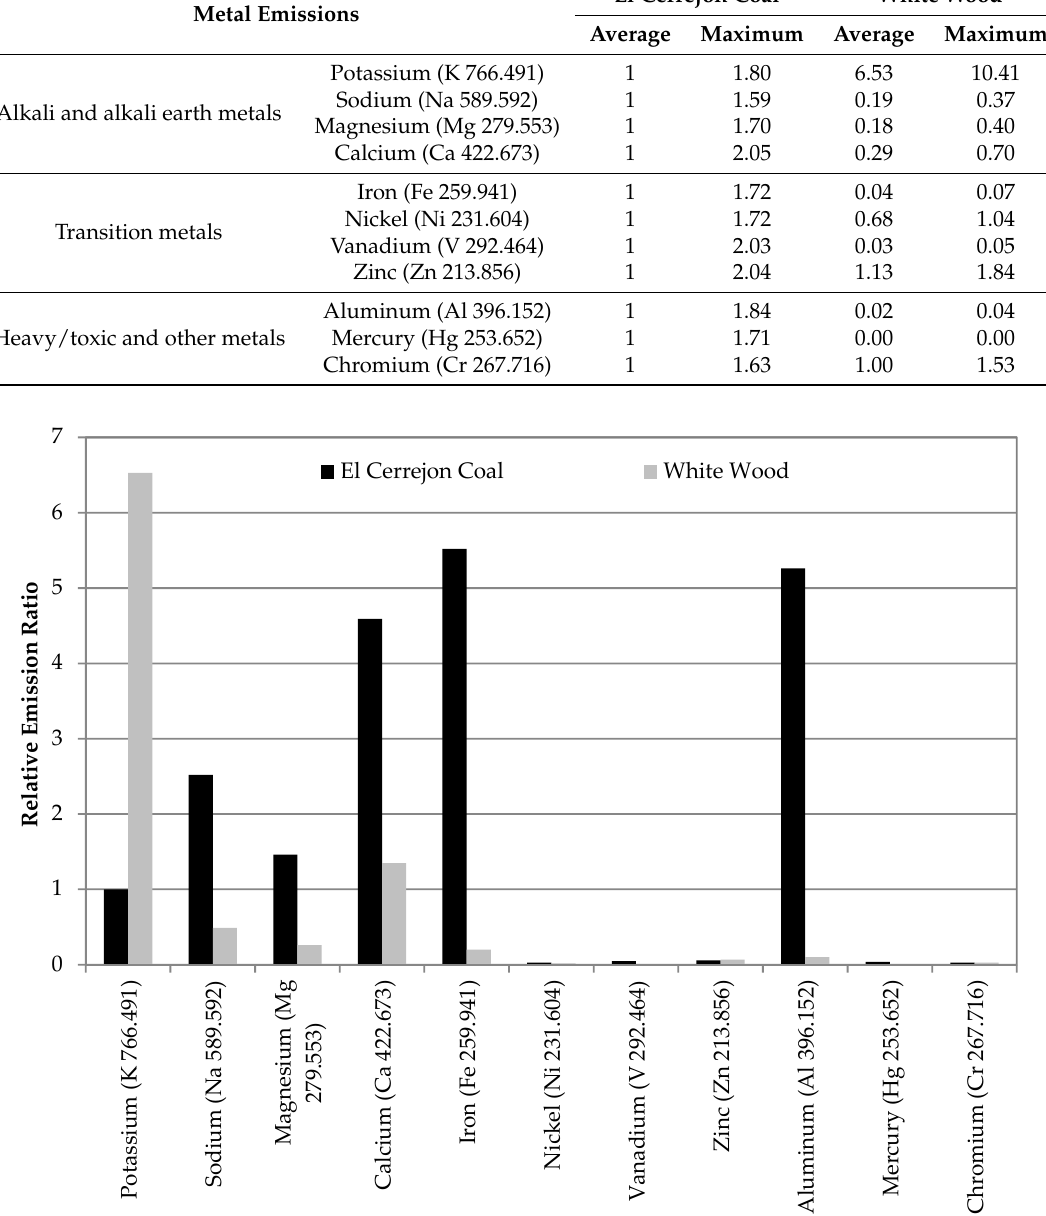
Figure 4. Average relative emission concentration ratios from coal and biomass combustion, compared to the average data for potassium from coal combustion (standardized to 1).